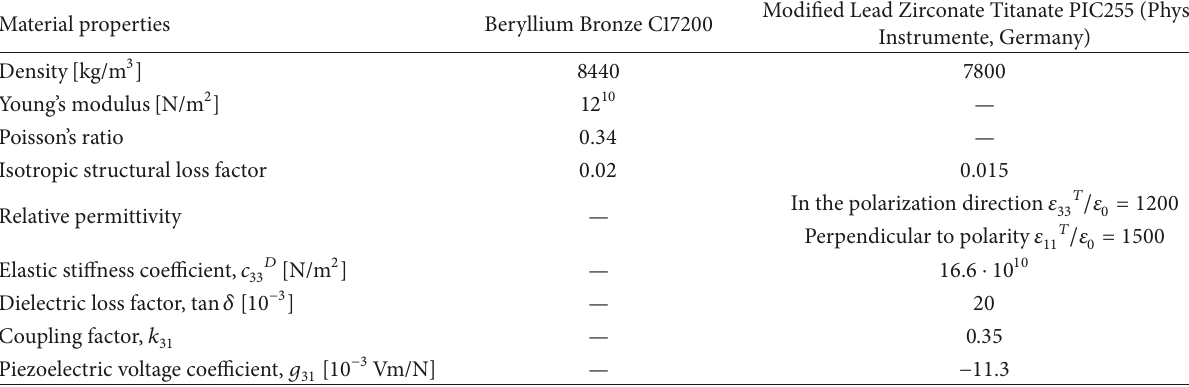
Table 2: Material